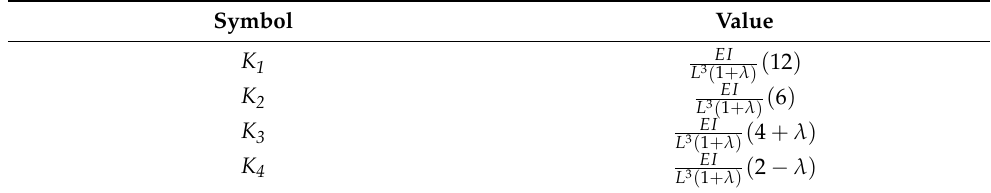
Table 2. Components of stiffness